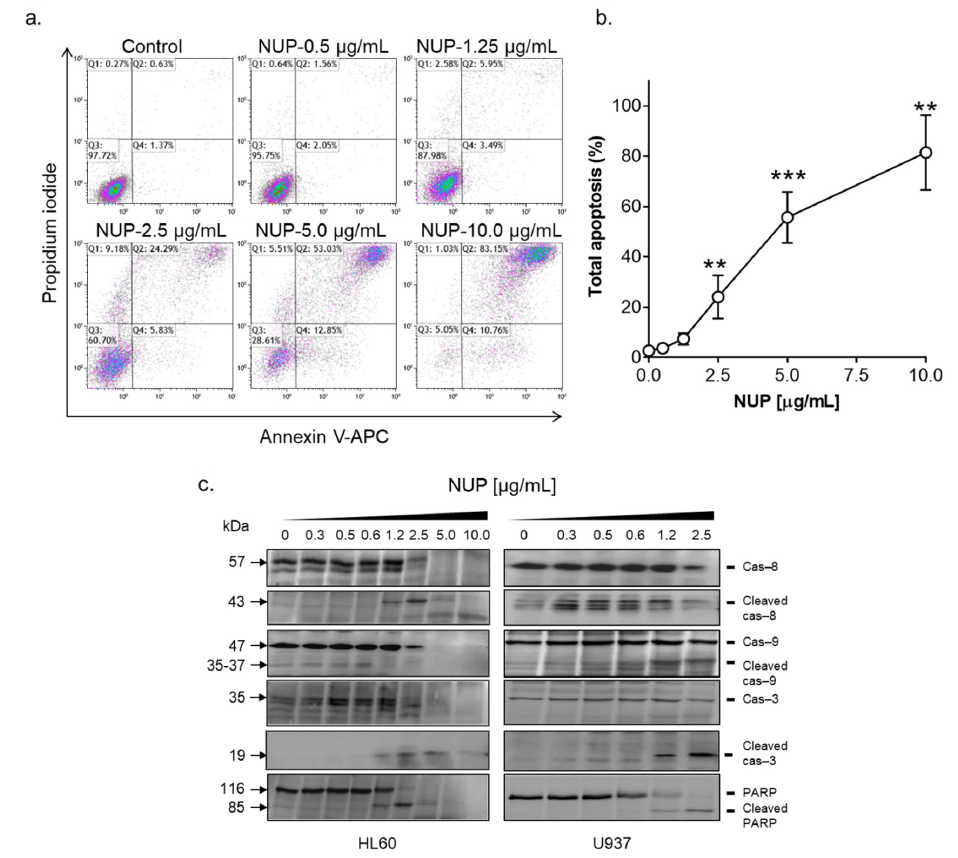
Figure 2. NUP induces apoptosis in AML cells. HL60 and U937 cells were treated with vehicle